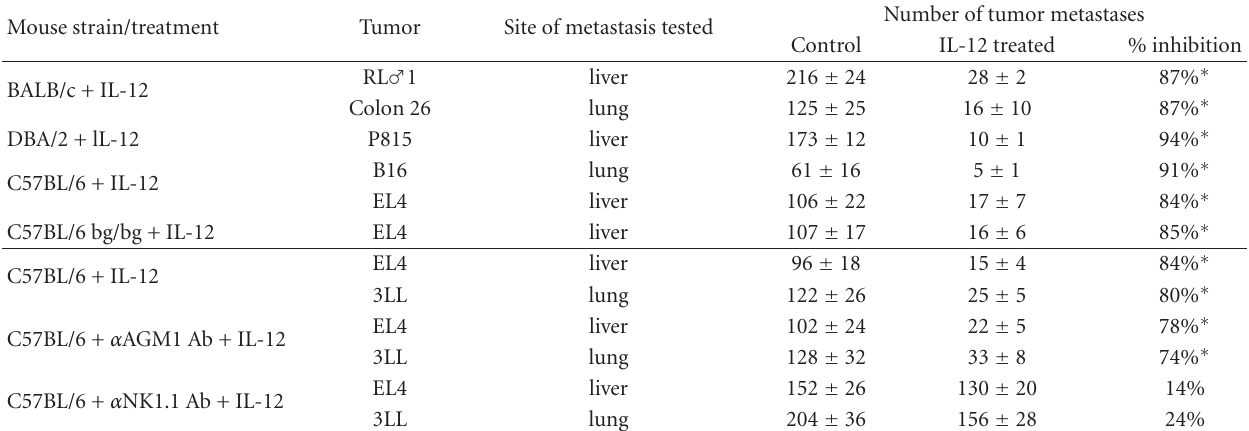
Table 1: NKT cells are IL-12-induced antimetastatic e ff